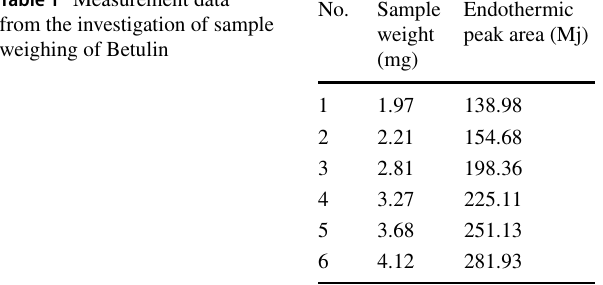
Table 1 Measurement data from the investigation of sample weighing of